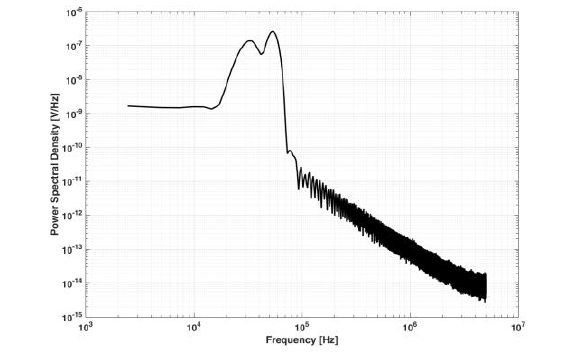
Figure 10. PSD of a transmitted US